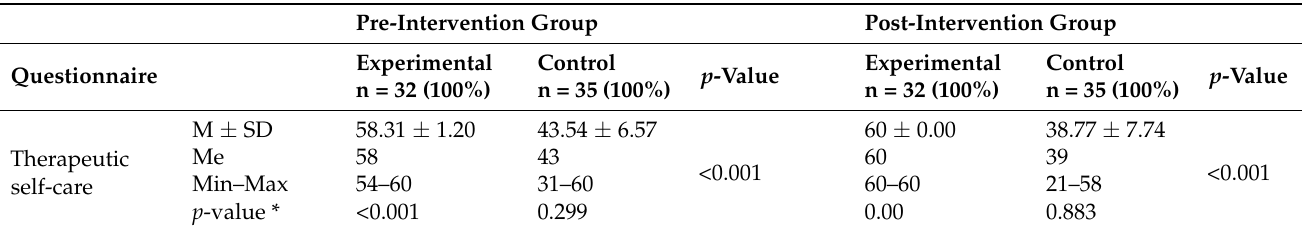
Table 5. Pre-intervention and post-intervention therapeutic self-care assessment scale